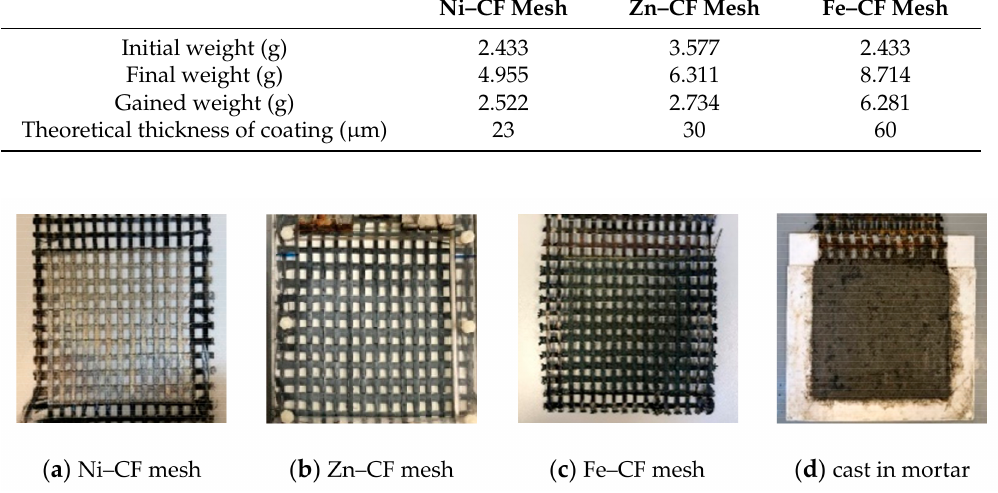
Figure 4. Images of metal-coated CF meshes ( a – c ) and an example of coated-metal CF mesh cast inside the cement-based electrolyte before demolding from the white plastic foam ( d ). The mixture of mortar is the same for the powder-mixing